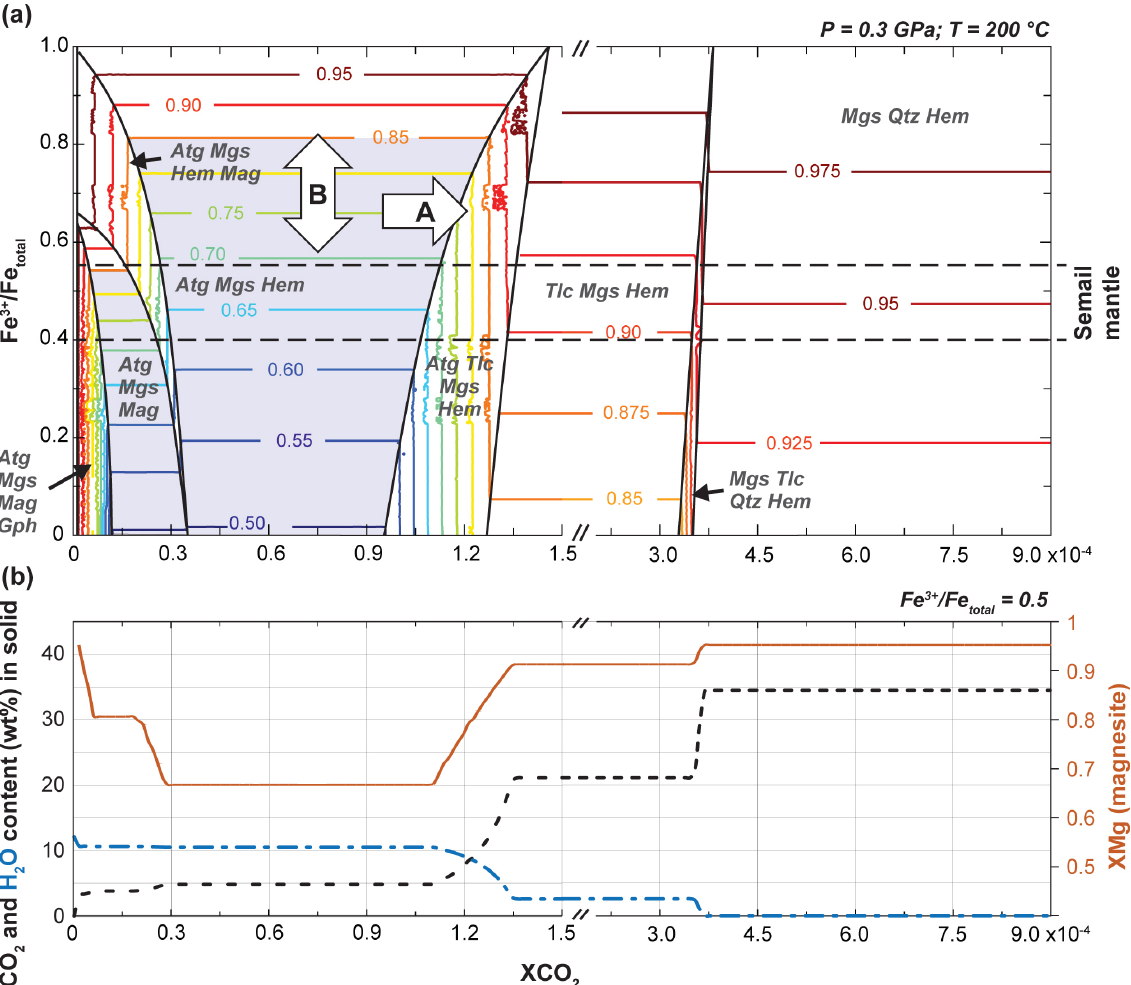
Figure 7. Model of Fe-partitioning in relation to carbonation and bulk rock redox budget. (a) Isobaric and isothermal, fluid-saturated XCO 2 pseudosection for a harzburgite bulk rock composition, with the y axis showing the redox budget expressed as Fe 3 + / Fe TOT (note that only in the small field at very low XCO 2 where graphite is predicted does the redox budget not directly equal Fe 3 + / Fe TOT here). Predicted XMg compositions of magnesite are shown as colored isopleths. (b) Plot of XMg of magnesite and CO 2 and H 2 O content in solid assemblage at a fixed redox budget of Fe 3 + / Fe TOT = 0 . 5, illustrating the expected changes in magnesite composition for the case of redox-neutral carbonation. Modeling was done using a simplified hydrated harzburgite composition with binary compositional mixing from reduced (SiO 2 – 38.77wt%; MgO – 39.21wt%; FeO – 6.99wt%) to fully oxidized (SiO 2 – 38.77wt%; MgO – 39.21wt%; Fe 2 O 3 – 7.77wt%) with saturated H 2 O and CO 2 . For illustration purposes the results of two calculations at the same conditions but different ranges of XCO 2 were combined (note the change in scaling of the x axis). Blue fields are for Fe-rich magnesite compositions (XMg < 0.85). The following mineral abbreviations are used. Atg: antigorite; Gph: graphite, Hem: hematite, Mag: magnetite, Mgs: magnesite, Qz: quartz, Tlc: